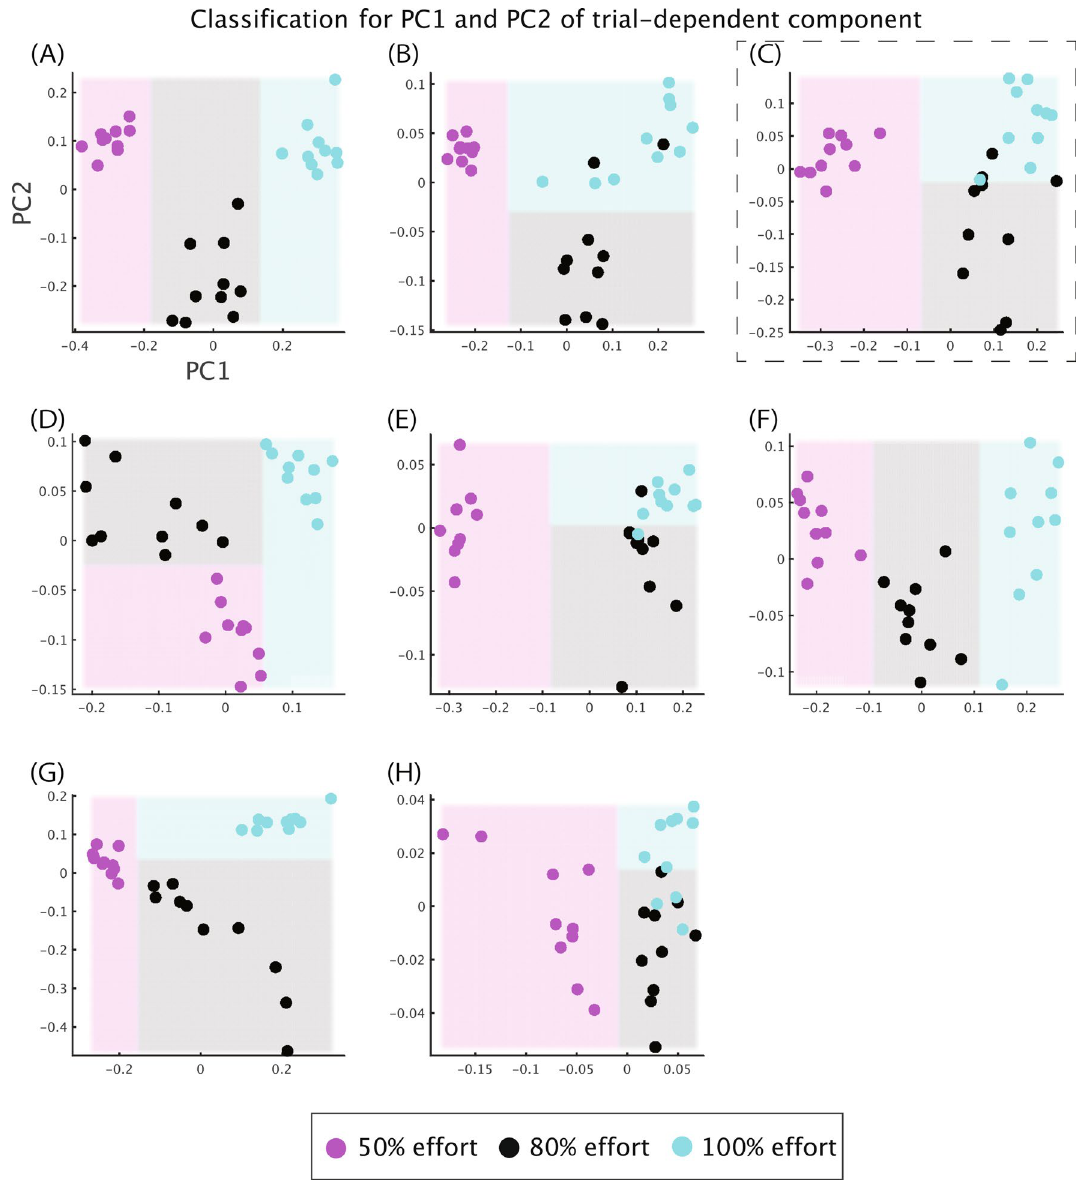
Figure 4. PC1 and PC2 of the trial components in each subject and the decision boundaries estimated by a classification tree algorithm. Horizontal and vertical axes indicate PC1 and PC2. Magenta, black, and cyan dots demonstrate the PC1 and PC2 values in each trial with 50%, 80%, and 100% effort, respectively. Magenta, black, and cyan areas denote the data area to be classified into 50%, 80%, and 100% effort estimated by the classification tree algorithm. Panels ( A – H ) denote the PC1 and PC2 values in each subject. Panel ( C ) surrounded by the black dotted rectangle corresponds to the typical subject in Fig.